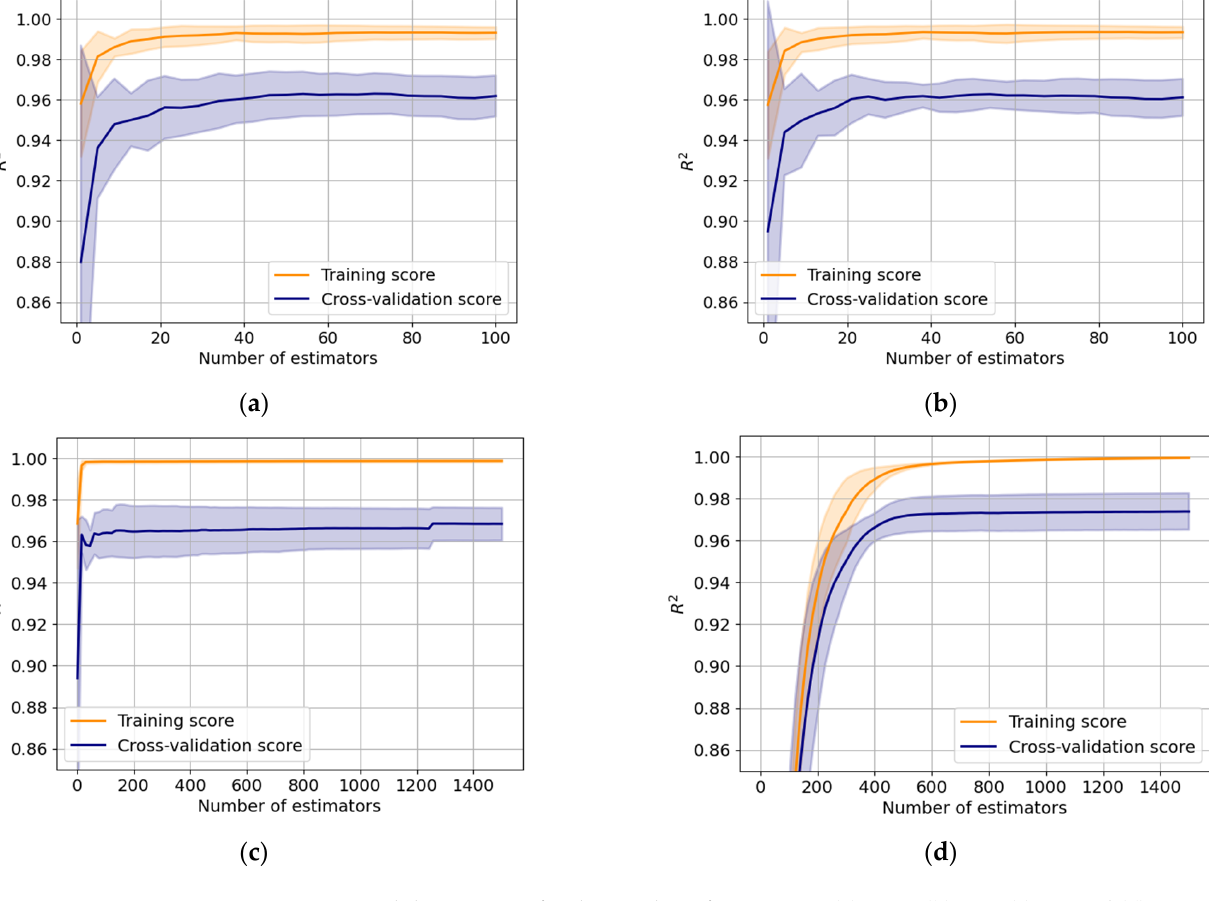
Figure 7. Validation curve for the number of estimators: ( a ) BME, ( b ) FRT, ( c ) AB and ( d ) GTB.